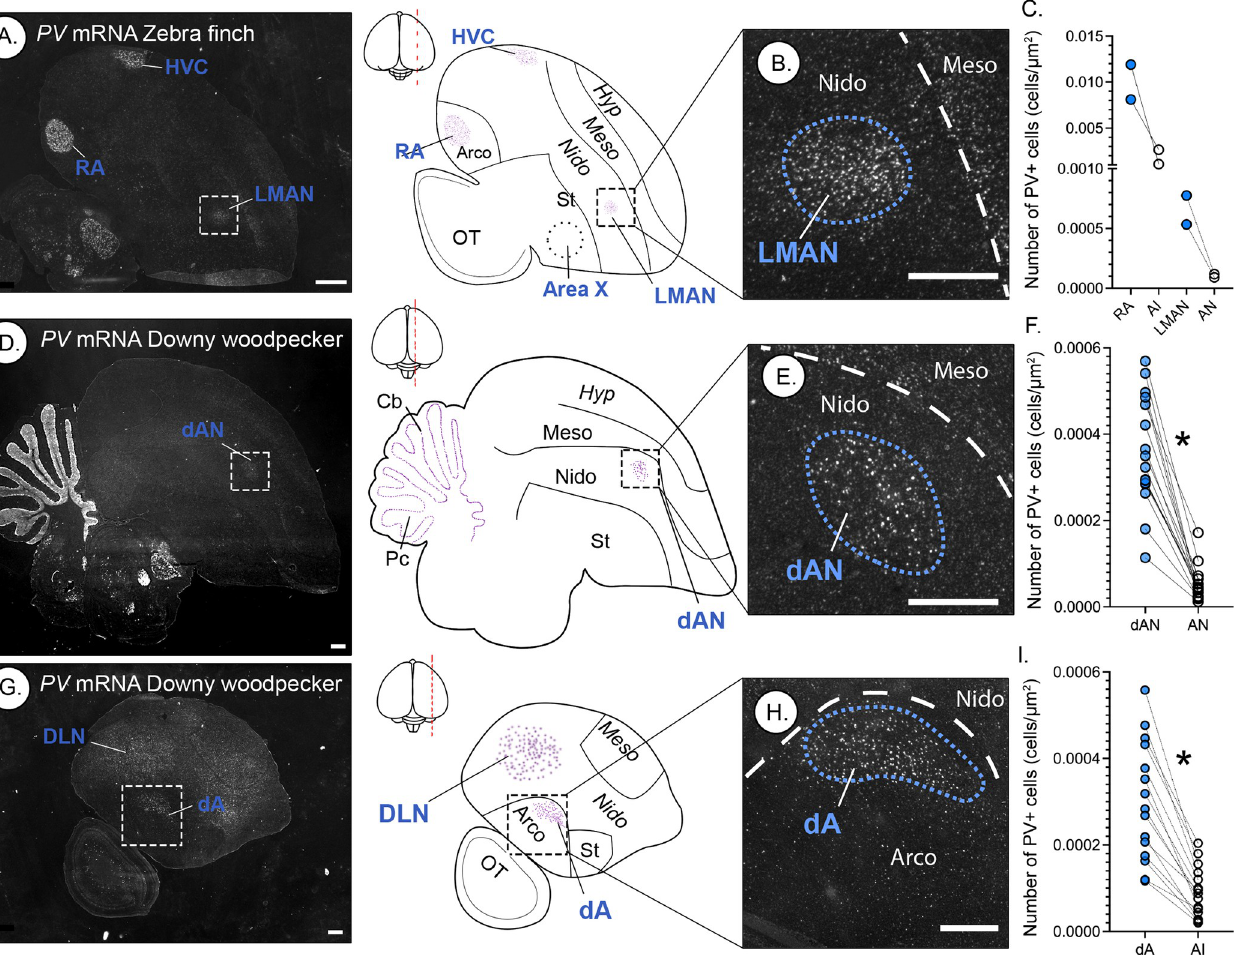
Fig 3. Parvalbumin ( PV ) specializations in the forebrain of male zebra finches and male downy woodpeckers. (A) Representative microscope image from inverted black and white colormetric in situ hybridization at low magnification of zebra finch brain sections, showing specialized up-regulation of PV mRNA expression in 3 of the 7 telencephalic song control nuclei including RA, HVC, and LMAN. Schematic diagrams next to the microscope image illustrate key neural anatomical subdivisions. Dashed circle in the zebra finch schematic drawing is the relative location of Area X as determined by other molecular markers on adjacent sections (see S4 Fig). (B) High-magnification image of the zebra finch LMAN area. (C) Number of PV + cells in 2 song control nuclei (RA and LMAN) compared to the expression in the surrounding arcopallium (intermediate arcopallium [AI]) or nidopallium (anterior nidopallium [AN]) in adult male zebra finches ( n = 2). (D-I) Representative images from low (D, G) and high (E, H) magnification with schematic illustrations of neuroanatomical regions with PV (dA, DLN, and dAN). (F, I) Graphical illustrations of the significant up-regulation of PV in the male downy woodpecker in (F) dAN ( n = 16; t p < 0.001) and (I) dA ( n = 16, t 30 = 5.91, p < 0.001) relative to the surrounding forebrain regions (AN and AI, respectively). Hyp, hyperpallium; arco, arcopallium; nido, nidopallium; Ot, optic tectum; St, striatum; Cb, cerebellum; Pc, cerebellar Purkinje cells. Scale bars represent 500 μ m. Dashed lines in high- magnification images indicate boundaries for different telencephalic regions (e.g., boundary between nidopallium and mesopallium), whereas blue dashed lines indicate specialized PV regions identified in zebra finches and downy woodpeckers. Asterisk ( � ) denotes significant differences between putative drumming nucleus and the surrounding pallium ( p < 0.05). Data for C, F, and I can be found in S1